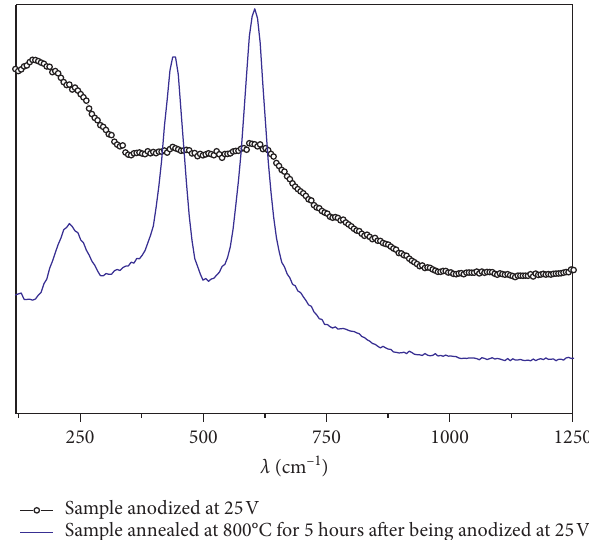
Figure 7: Raman spectra obtained for anodized sample at 25 V before and after annealing at 800 ° C for 5